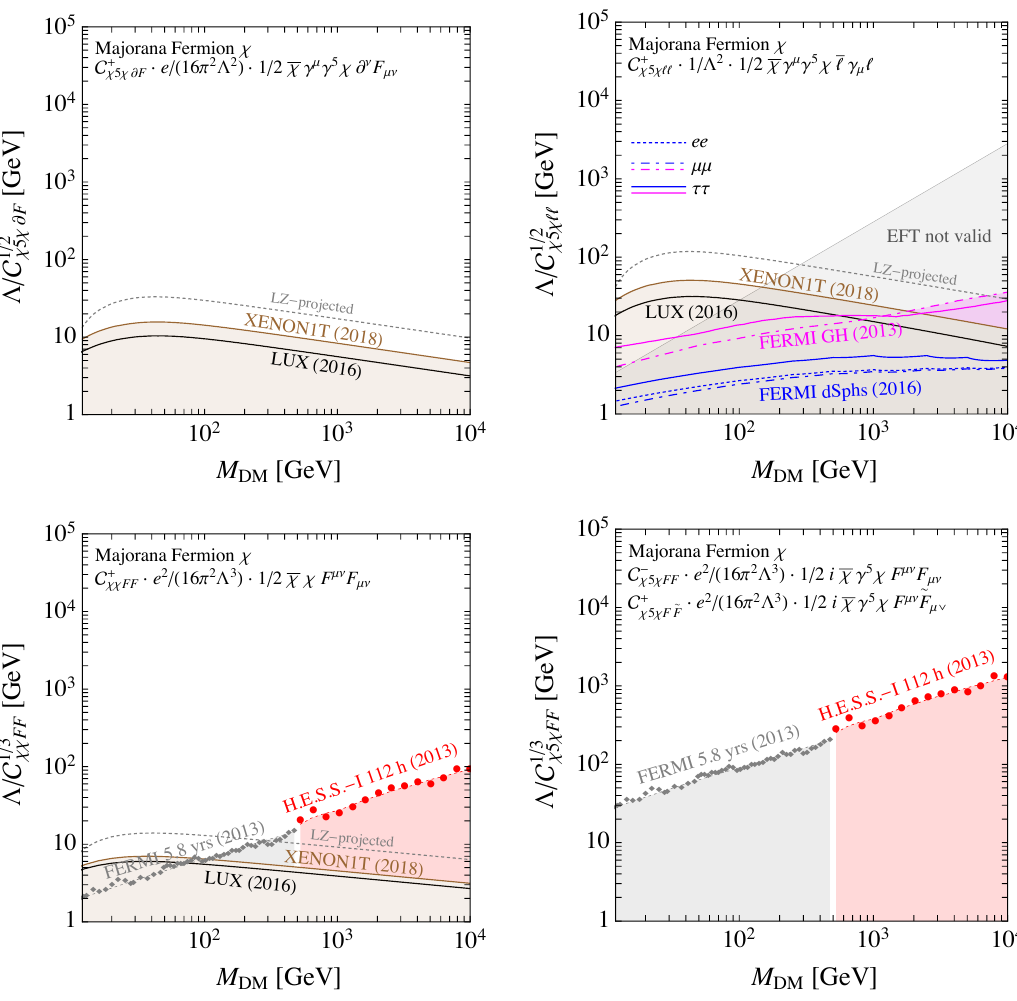
Figure 2 . Same as (cid:12)gure 1 but for Majorana Fermion Dark Matter (cid:31) . Note that bounds on the operators and (both shown in the bottom right panel) are O (cid:31) 5 (cid:31)FF O (cid:31) 5 (cid:31)F ~ F